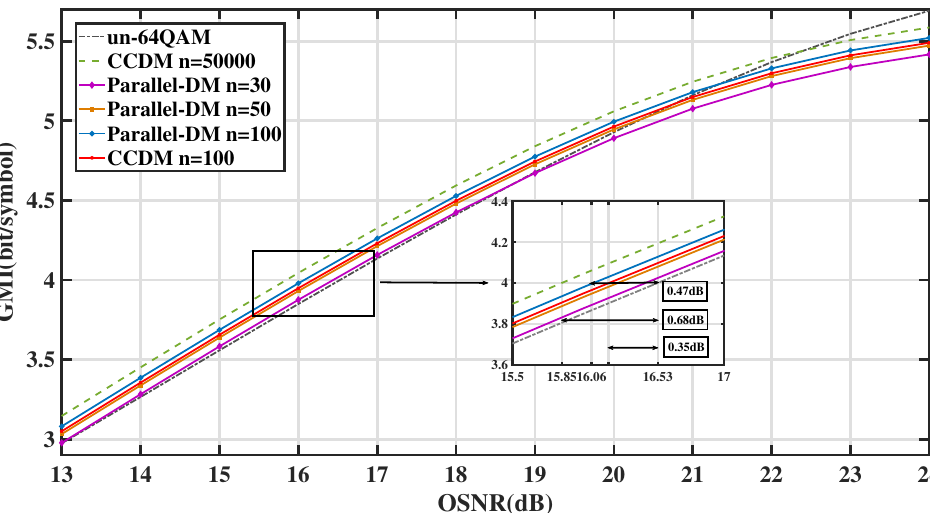
Figure 5. GMI in bit/symbol over OSNR in dB for bit-metric decoding and PS-64QAM. The inset zooms into the region around GMI = 4 bit/symbol, where the parallel distribution matcher of length n = 100 is 0.47 dB more power-efficient than uniform 64QAM, and is 0.12 dB more power-efficient than PS-64QAM using